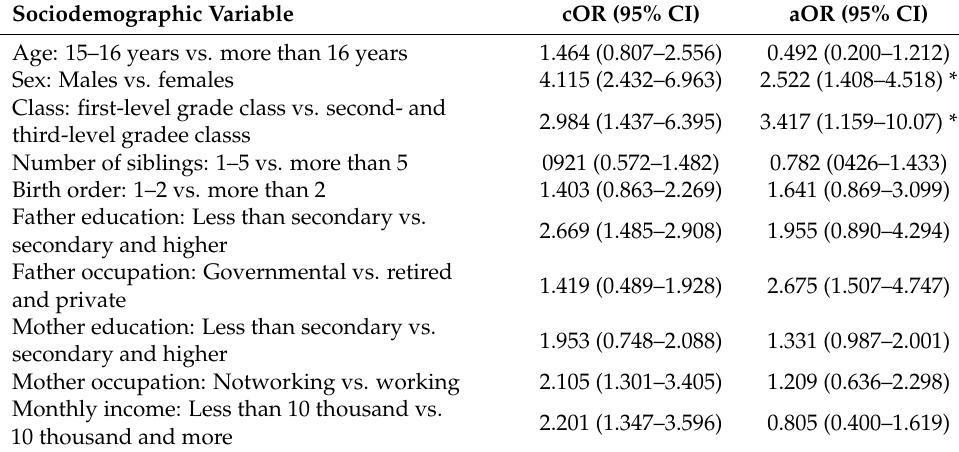
Table 2. Univariate and multivariable analysis of sociodemographic factors associated with bullying among secondary school students in Khamis Mushait city, southwestern Saudi Arabia ( n =